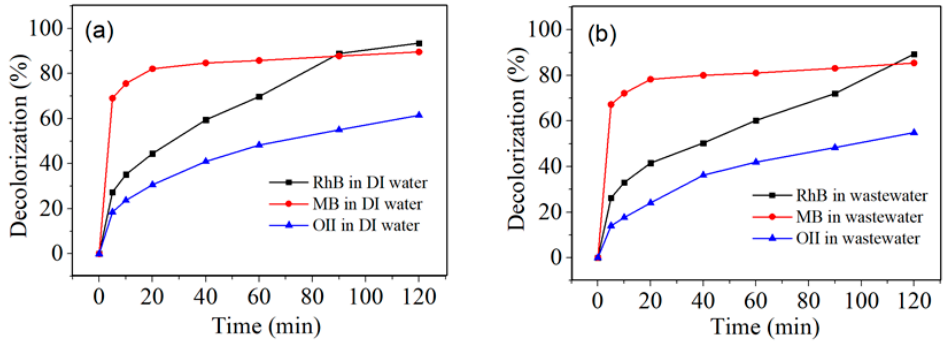
Figure 9. The catalytic efficiency of the Fe 3 O 4 @GO + K 2 S 2 O 8 system in ( a ) deionized water and ( b ) real wastewater effluent